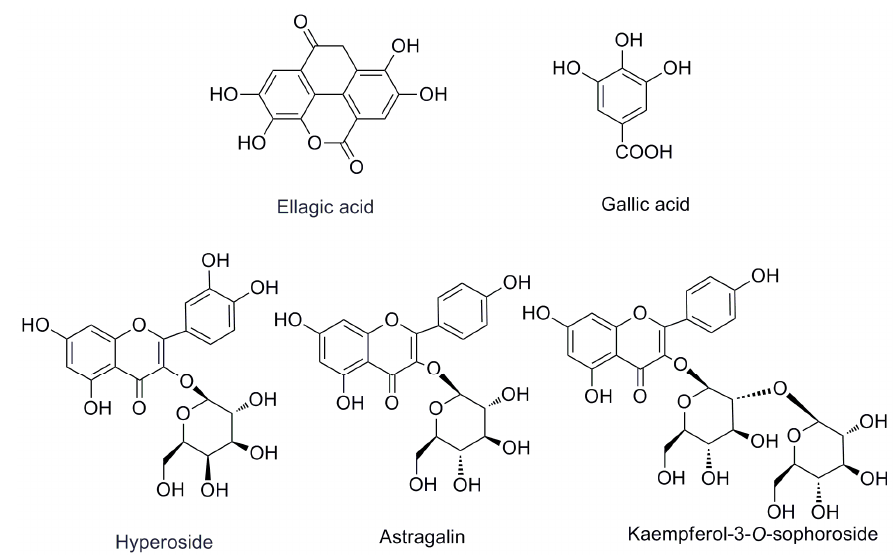
Figure 1. The chemical structures of the investigated compounds.